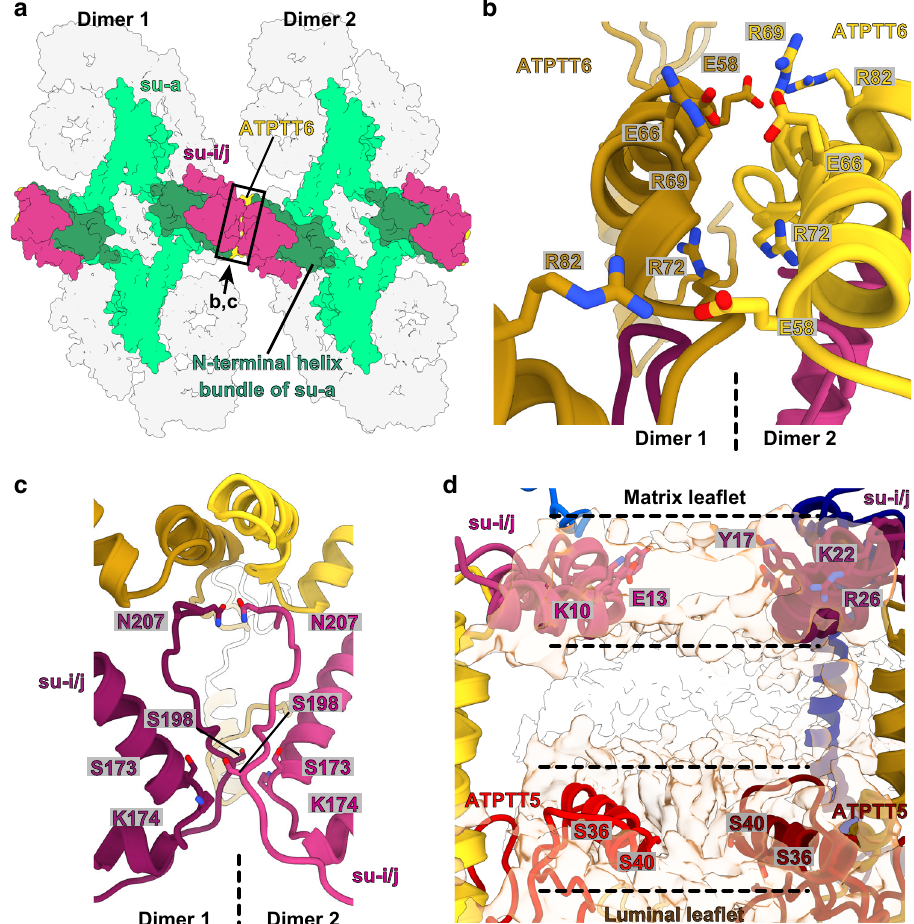
Fig. 7 Type III ATP synthase tetramer interacts via speci fi c protein and lipid-mediated interfaces. a Luminal view of the tetramer. The N-terminal four- helix bundle of subunit- a (dark green) positions subunit- i / j and ATPTT6 for tetramer interactions. Boxed region and arrow indicate region and view direction shown in close-up view in b , c . b ATPTT6 subunits in the two dimers form electrostatic interactions. c Subunits- i/j in the interface form polar interactions. d Subunits i/j and ATPTT5 interact via bound membrane lipids in the matrix lea fl et (black dashed lines) and luminal lea fl et (gray dashed lines). Unmodeled lipid density is shown in transparent light brown